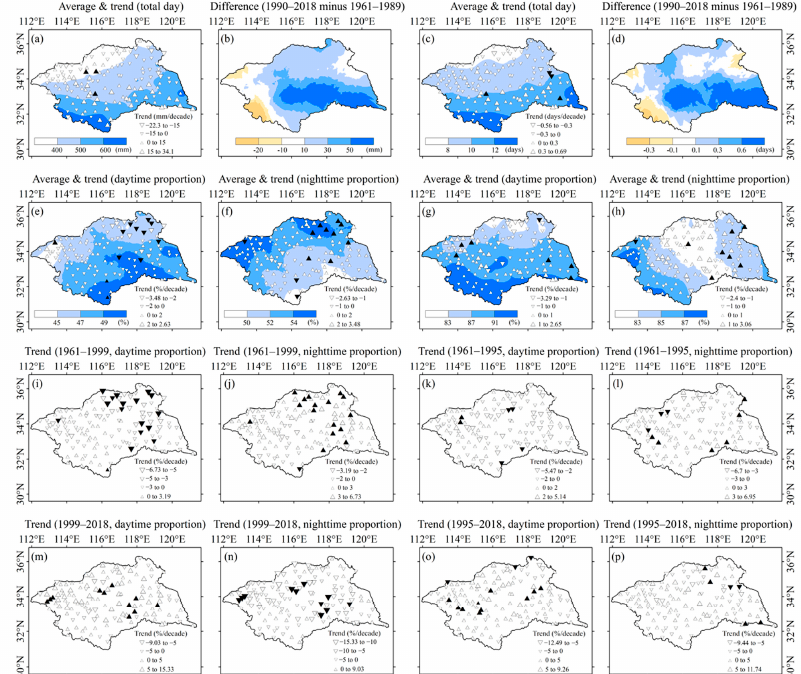
Figure 14. ( a ) Climatology and trend characteristics of TR90p during 1961–2018 and ( b ) the mean difference in TR90p between 1990–2018 and 1961–1989. ( c ) Climatology and trend characteristics of TR90p days during 1961–2018, ( d ) the mean difference in TR90p between 1990–2018 and 1961–1989. ( e , f ) Spatial proportions of the daytime and nighttime precipitation to TR90p, and ( g , h ) spatial proportions of the numbers of daytime and nighttime precipitation events to TR90p. ( i , j ) Spatial proportion trends of daytime and nighttime precipitation to TR90p during 1961–1999, and ( k , l ) spatial proportions of the numbers of daytime and nighttime precipitation events to TR90p during